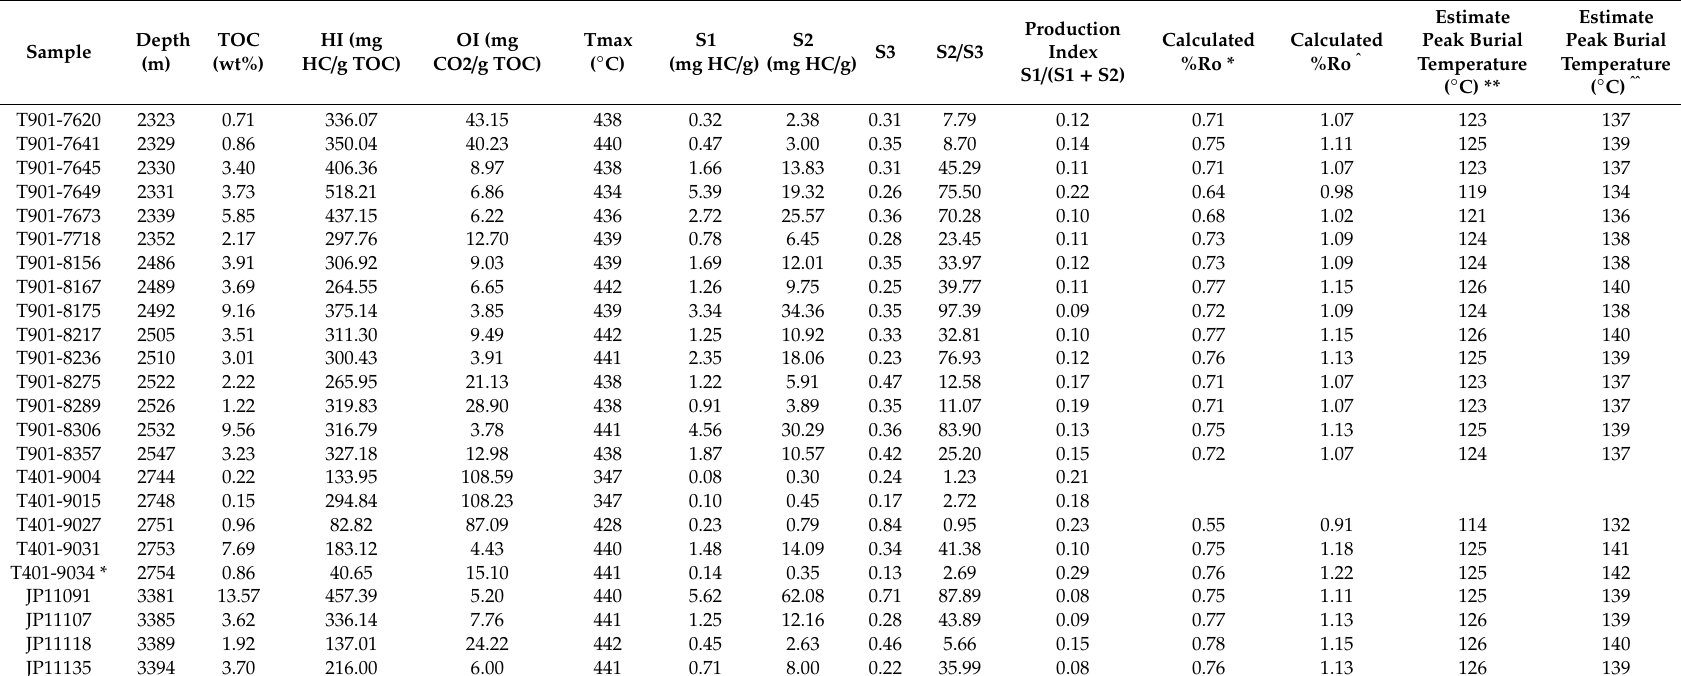
Table 2. Rock-Eval pyrolysis data from analyzed samples from the Midland